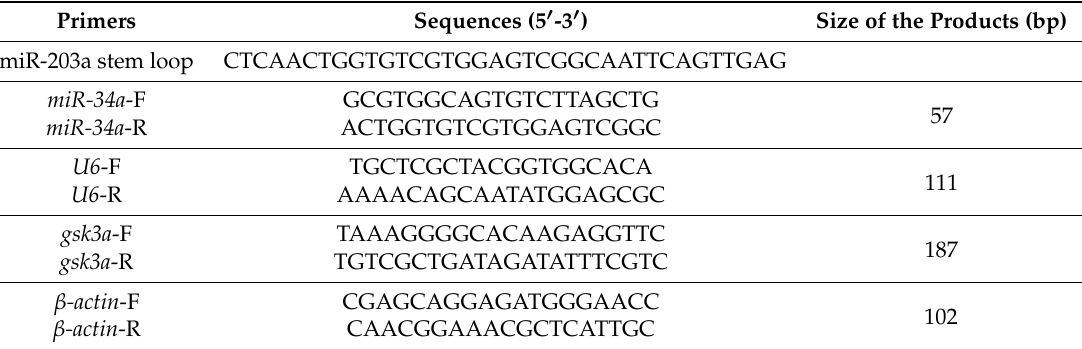
Table 2. The primers used for conducting qRT-PCR